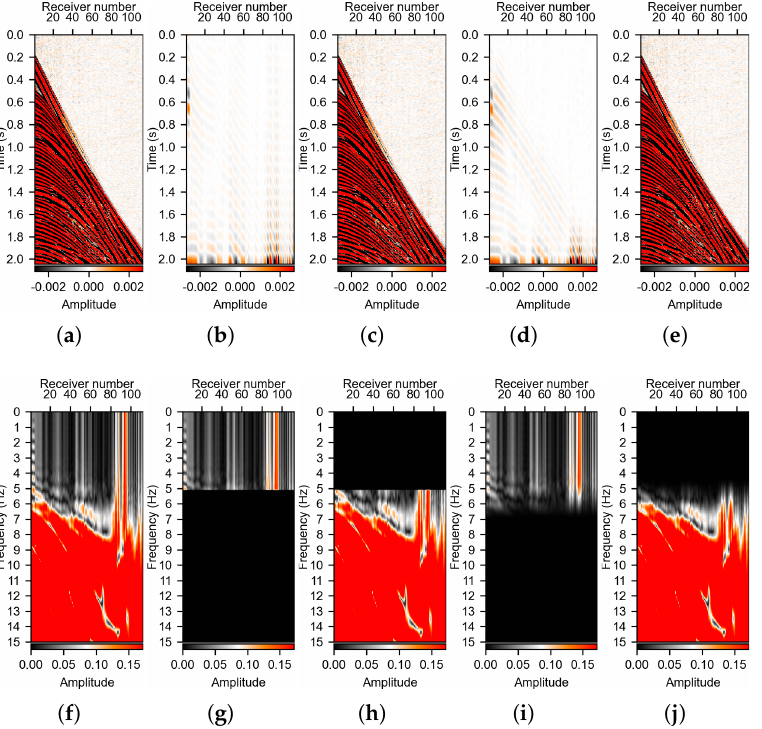
Figure 3. Splitting the low- and high-frequency data (shot gather 2D view). ( a ) A shot gather of the Mobil AVO Viking Graben Line 12 dataset [33,34]. ( b ) Hard split LF (<5 Hz) data in the time domain. ( c ) Hard split HF ( (cid:62) 5 Hz) data in the time domain. ( d ) Soft split LF data in the time domain. ( e ) Soft split HF data in the time domain. Panels ( f – j ) show the Fourier amplitude spectrum of the data shown in panels ( a – e ), respectively. Note that the Gibbs effect shown in panels ( b , c ) is successfully eliminated in panels ( d , e ) by the designed splitting window. There are artifacts formed at the bottoms of subfigures ( b , d ), which are caused by the sudden cutoff in the time domain. Those artifacts can be further suppressed by applying a smooth tapering calculated by Equation